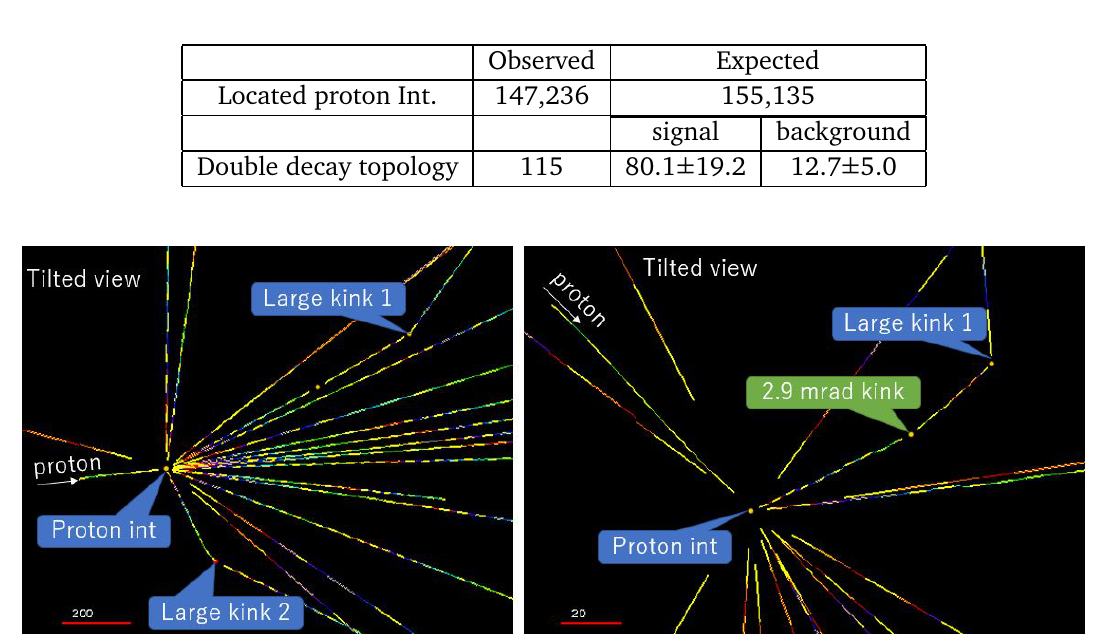
Figure 2: An event with two large kinks detected in the pilot run data. One of the kink parents has a small kink of 2.9